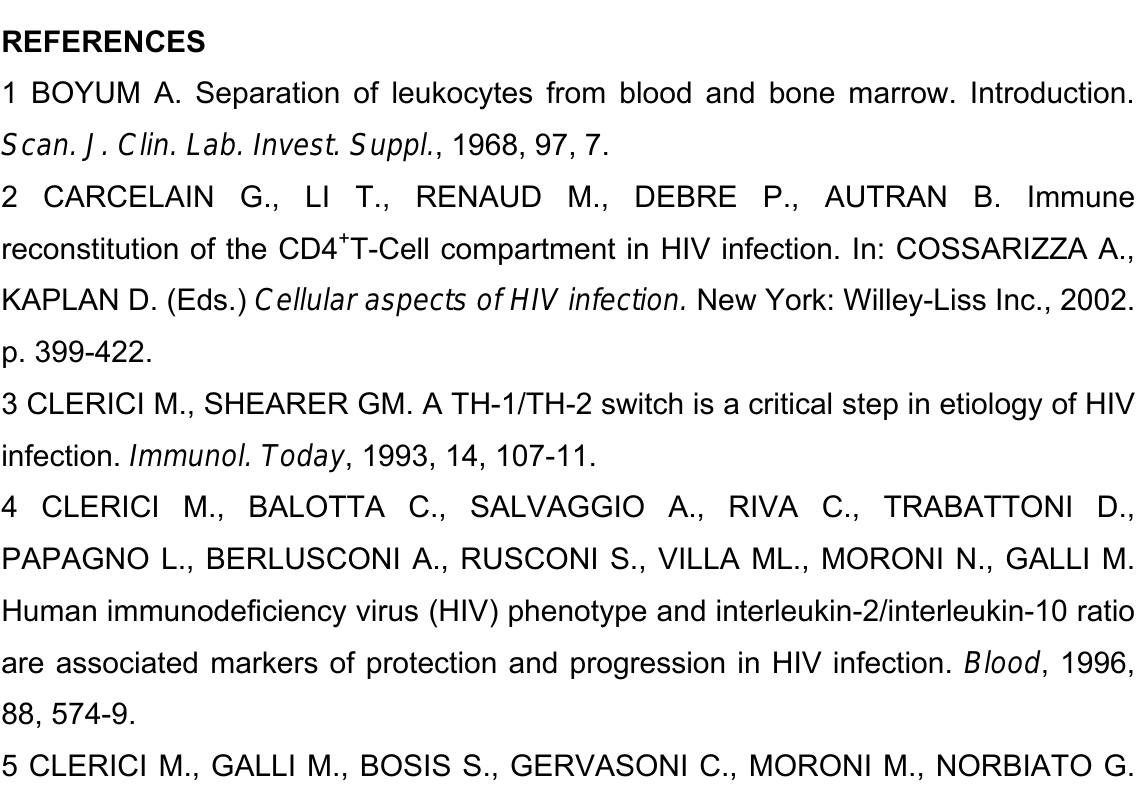
D. A. Meira et al. ASSESSMENT OF CYTOKINE VALUES IN SERUM BY RT-PCR IN HIV-1 INFECTED INDIVIDUALS WITH AND WITHOUT HIGHLY ACTIVE ANTI-RETROVIRAL THERAPY (HAART). J. Venom. Anim. Toxins incl. Trop. Dis ., 2008, 14, 4, p.